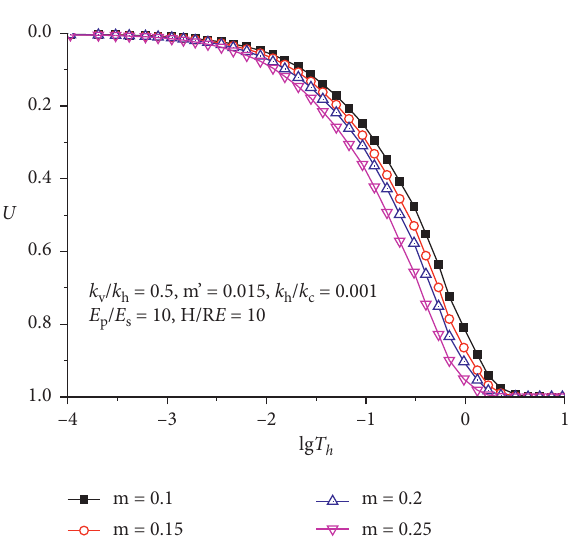
Figure 6: Influence of pile-soil modulus ratio on consolidation rate of foundation.